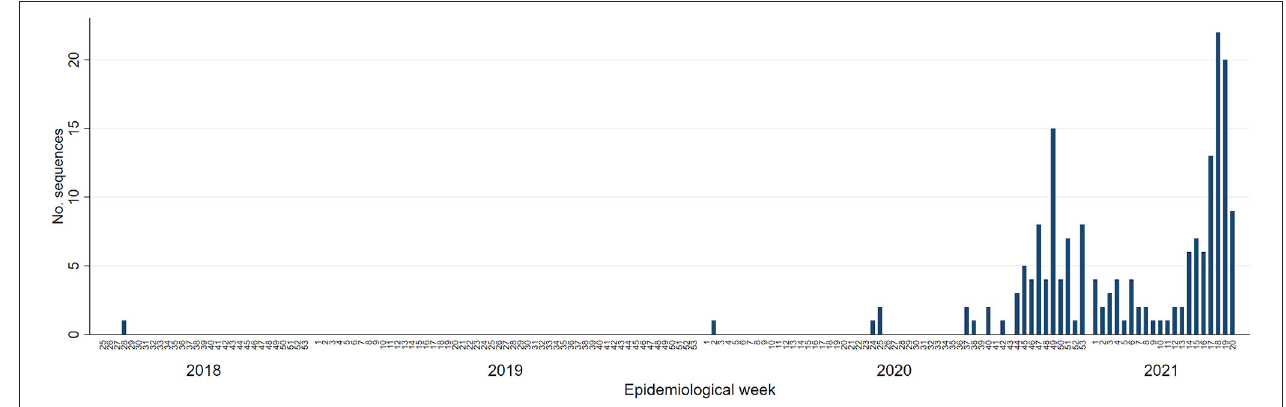
FIGURE 1 | Epidemic curve of the Porcine Reproductive and Respiratory Syndrome Virus Lineage 1C variant associated with this outbreak by epidemiological week amongst participants of the Morrison Swine Health Monitoring Project in the United States, January 2018 to May